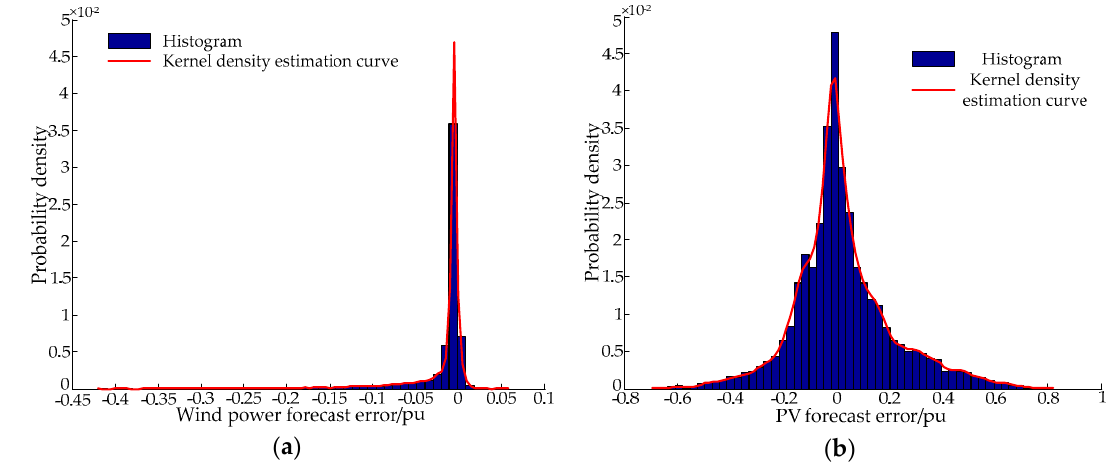
Figure 2. Fitting of probabilistic distribution of WP ( a ) and PV power prediction error ( b ).